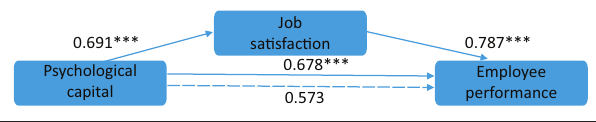
Note: The solid arrows between the variables denote direct paths, whilst the dotted arrow denotes the beta coefficient of equation, including both psychological capital and employee engagement as predictors of employee performance. The values denote standard beta weights ( β ). FIGURE 8: Employee engagement mediation analysis